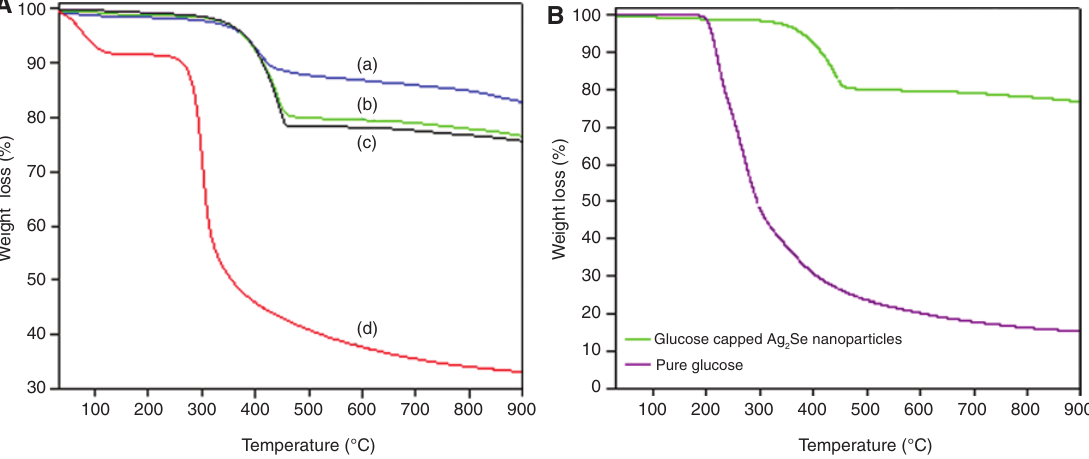
Se nanoparticles capped with green tea (a), glucose (b), ascorbic acid (c) and 2